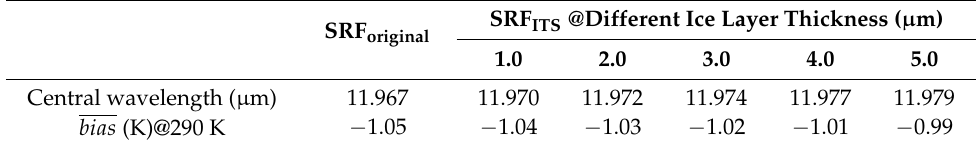
Table 2. Statistical results of SRF ITS impact on the central wavelength and bias of the FY-2G IR2 band.